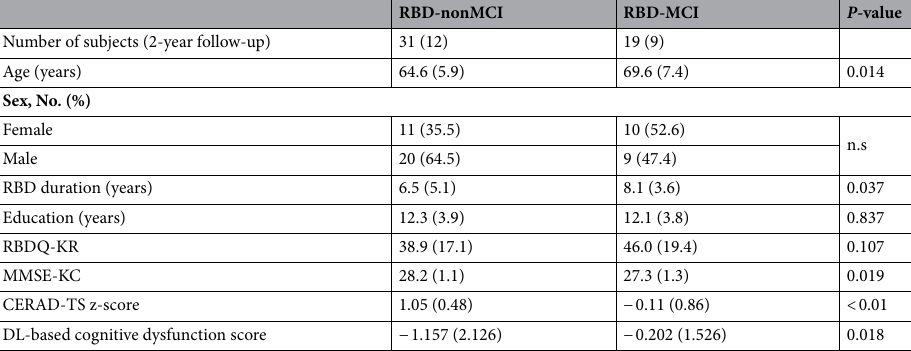
Table 1. Demographics, clinical characteristics, and DL-based cognitive dysfunction scores of iRBD cohort. RBD rapid eye movement sleep behavior disorder, MCI mild cognitive impairment, RBD-nonMCI iRBD